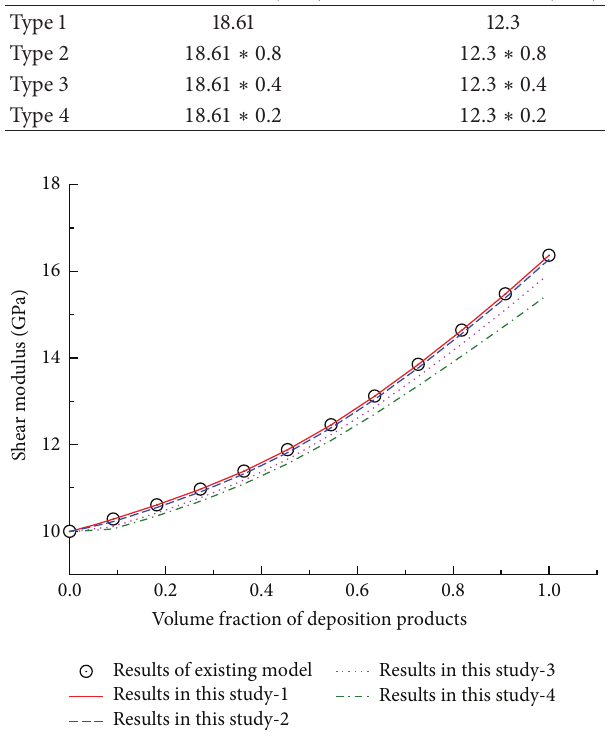
Figure 5: Comparisons of shear modulus between our predictions and those of existing model [15] during healing process, with 1, 2, 3, and 4 representing results obtained with the first, second, third, and fourth types of